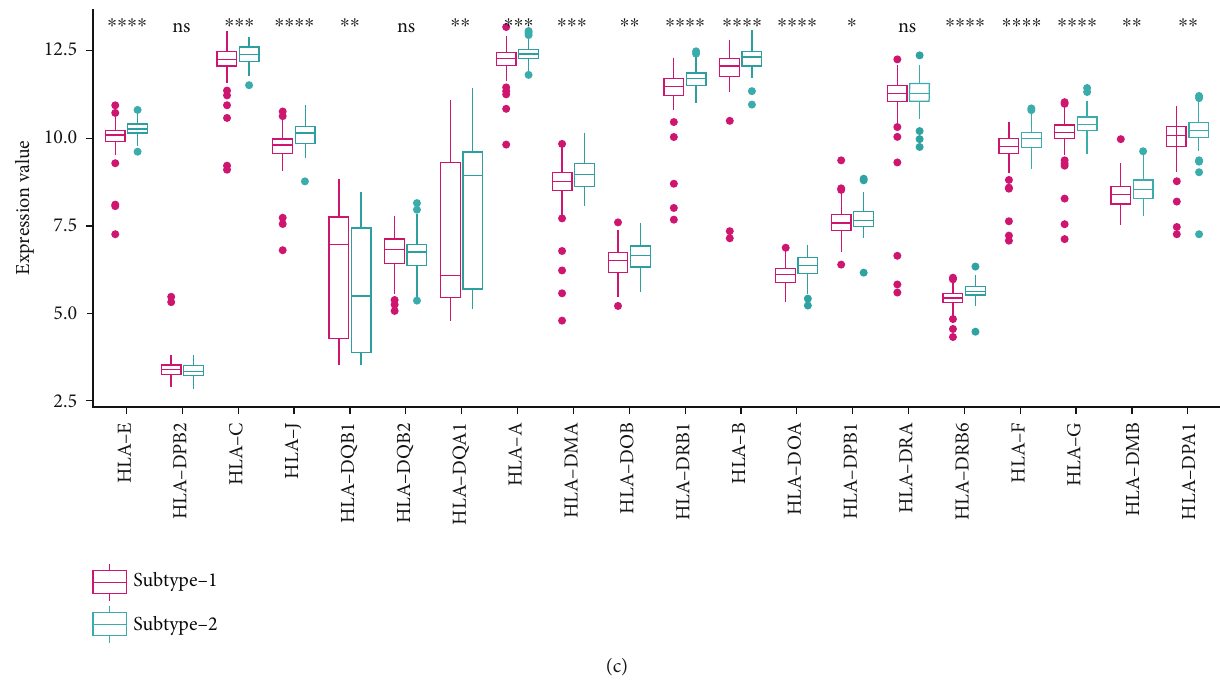
Figure 7: Immune characteristics in the two RBP regulatory subtypes. (a) Immunocyte in fi ltration status in the two RBP regulatory subtypes. (b) Activity of immune pathways in the two RBP regulatory subtypes. (c) HLA expression levels in the two RBP regulatory